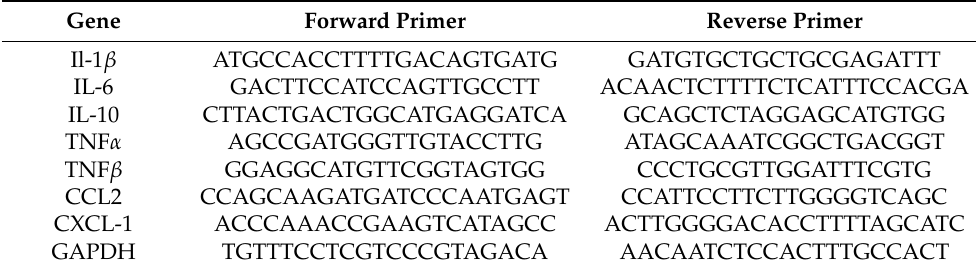
Table 1. Primer sequences for real-time